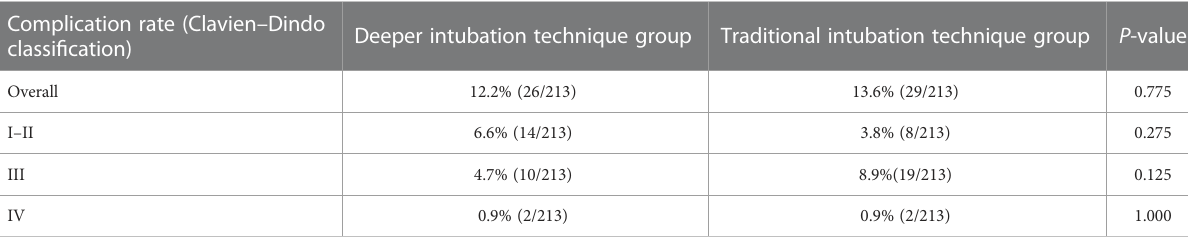
TABLE 3 Detailed overview of the complications.